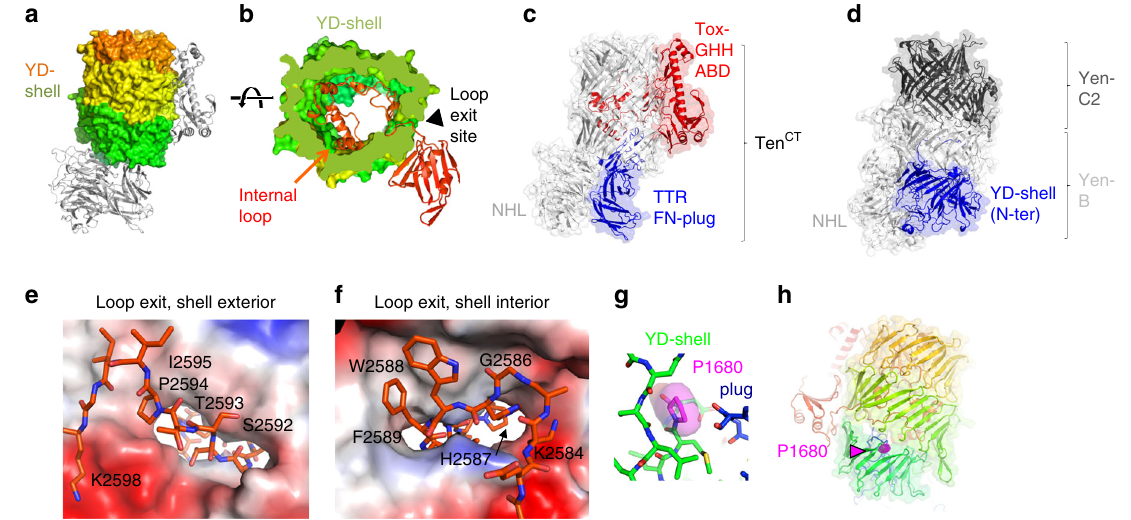
Fig. 4 The YD shell and internal linker. a The Ten2 YD-shell domain is shown in surface representation and coloured as in Fig. 1b. The rest of the protein is shown as grey ribbons, oriented as in Fig. 1b. b A cut-through view of the YD shell (green) shown as a surface view. The internal loop and ABD (red) are shown as ribbons. The loop exit site on the shell is indicated. c Ten2 CT is shown in ribbons and transparent surface. The C-terminal domains not present in previously determined structures of bacterial toxin proteins 22,23 are shown in red; the N-terminal FN-Plug and TTR domains, which lie upstream of the NHL domain, are in blue. d The structure of YenB/YenC2 is shown for comparison with Ten2 in c . Here the NHL domain is inserted into the YD-repeat domain. YD repeats that lie upstream of the NHL domain are shown in blue. e , f Zoomed views of the outside ( e ) and inside ( f ) surfaces of the YD shell at the loop exit site. The shell surface is coloured according to charge (negative = red, positive = blue, uncharged = white). The exiting loop is shown in red and as sticks. g Zoomed view of the conserved proline residue (P1680 in Ten2), mutated in Teneurin1-dependent anosmia, shown in magenta. Otherwise the colours are as in Fig. 1. h The position of the residue P1680 (shown as magenta spheres) is shown mapped onto the structure of Ten2 CT . The rest of the model is shown as ribbons and coloured as in Fig.